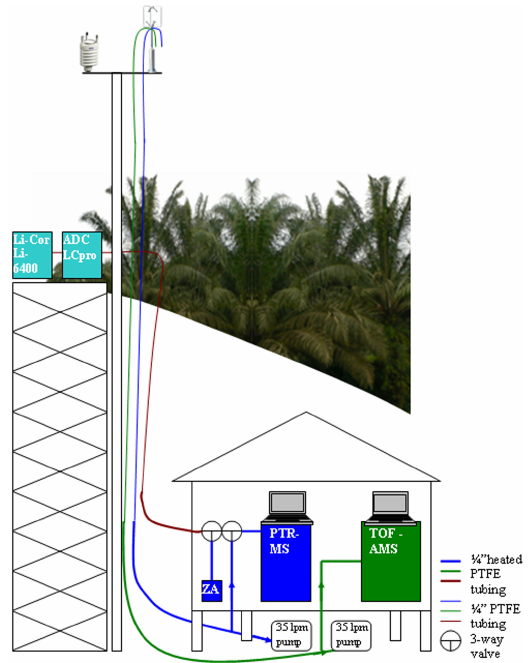
Fig. 1. Schematic of the sampling setup at the Sabahmas Oil Palm plantation, Borneo. Measurements of estragole (and other VOCs) were made at canopy and leaf level using proton-transfer-reaction mass spectrometry (PTR-MS) and leaf cuvettes (Li-COR Li-6400 and ADC LCpro). ZA refers to the zero-air (pure air) generator, and TOF-AMS refers to a time-of-flight aerosol mass spectrometer deployed at the site. In addition, a portable gas chromatograph with a mass spectrometer (Hapsite Smart, Inficon, East Syracuse NY) was used (not presented here) for ambient air and enclosure in-situ